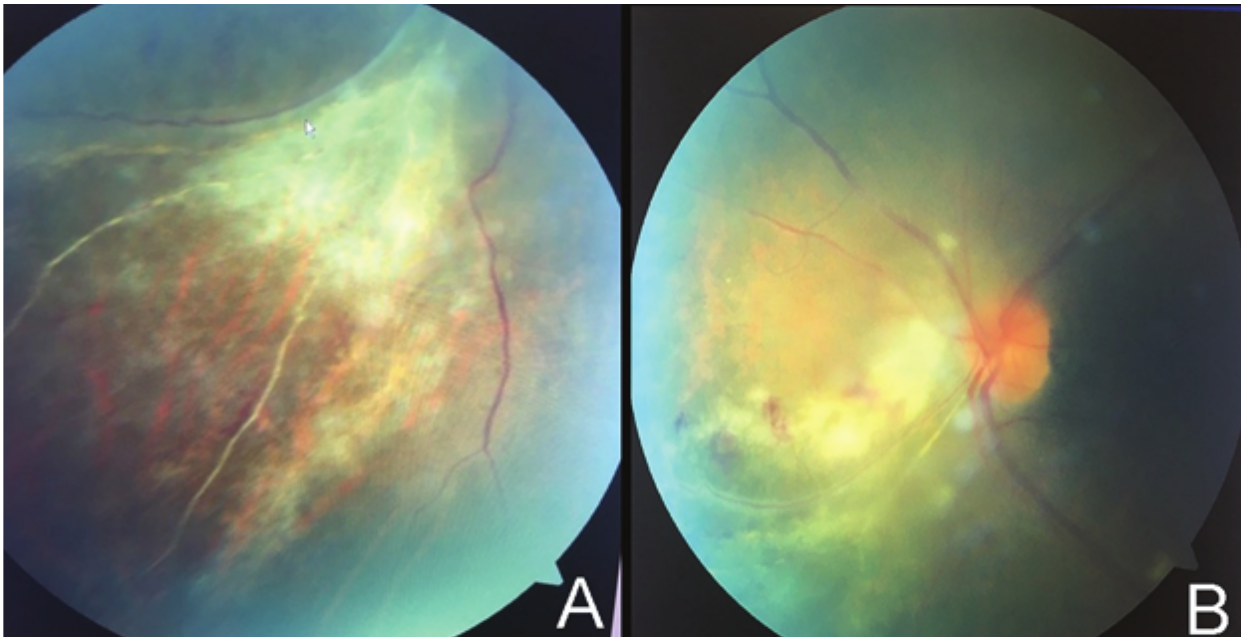
Figure 1. (A) A funduscopic photo of the left eye shows fluffy white lesions with intraretinal hemorrhage predominantly in the inferonasal quadrant. (B) A funduscopic photo of the left inferonasal quadrant five weeks after treatment initiation.